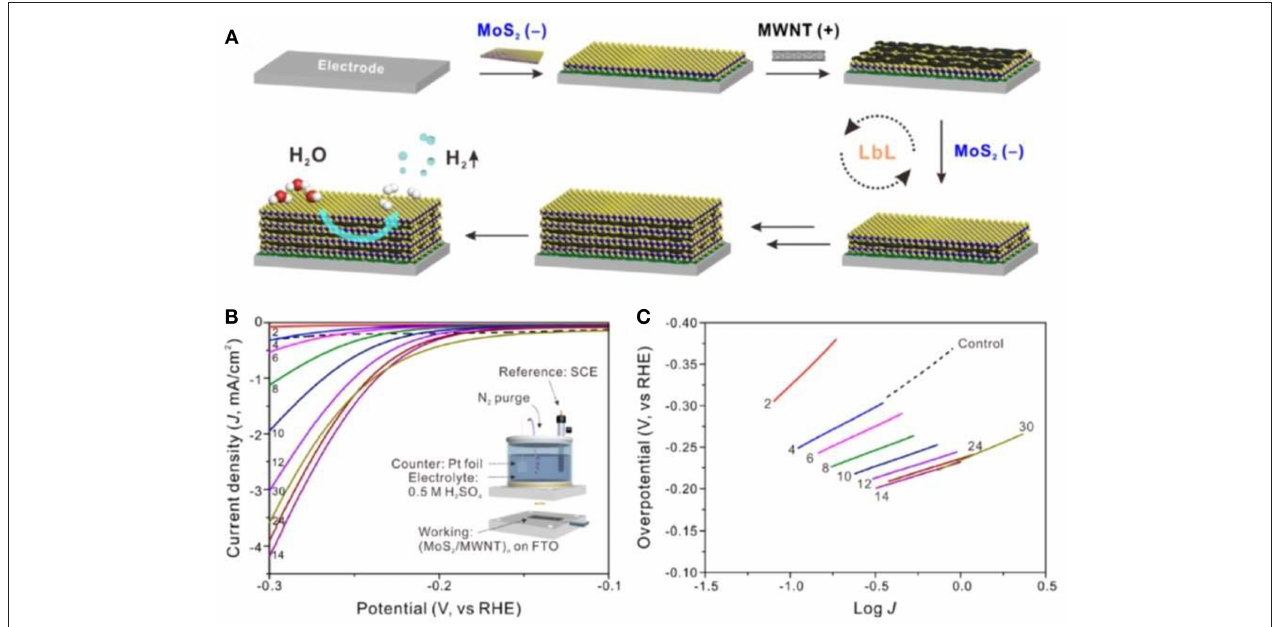
FIGURE 3 | (A) Schematic of the LbL assembly of (MoS 2 /MWNT) n multilayer electrode, (B) Polarization curves of hybrid multilayer (MoS 2 /MWNT) n electrodes (Inset of B is the experimental setup of the three-electrode system), (C) Corresponding Tafel plots (Ahn and Kim, 2017).